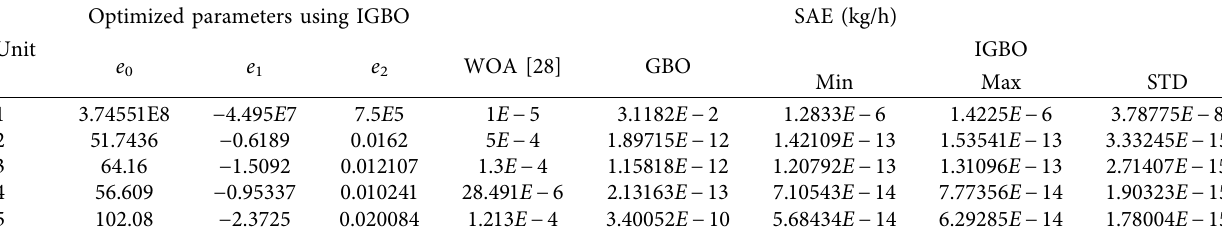
Table 11: Optimized parameters and SAE of model